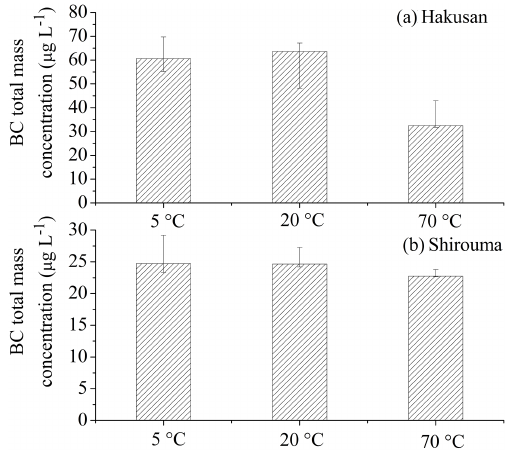
Figure 1. Total mass concentration of BC in (a) Hakusan and (b) Shirouma snow samples melted at 5, 20, and 70 ◦